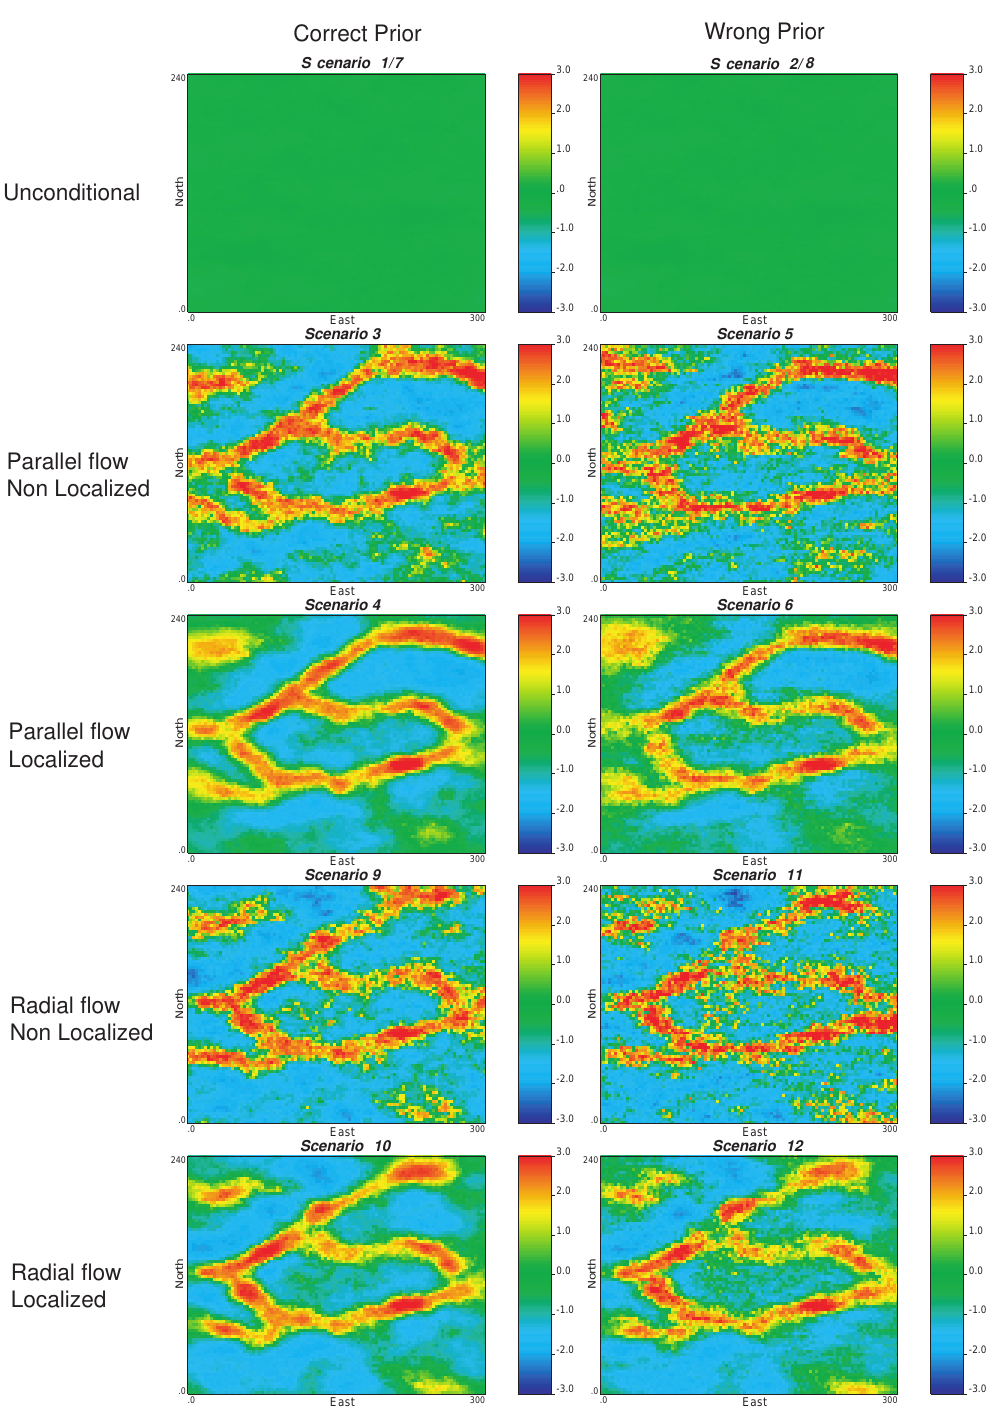
Fig. 5. Ensemble average logconductivity fields at time step nT =60 for the different scenarios.